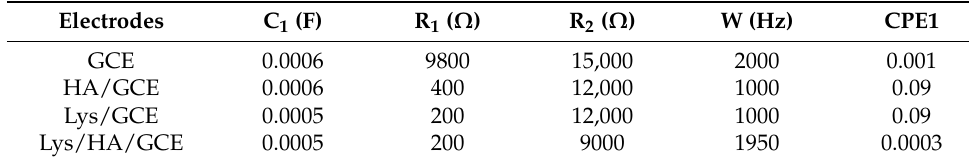
Table 2. Values taken by the different elements of each circuit.